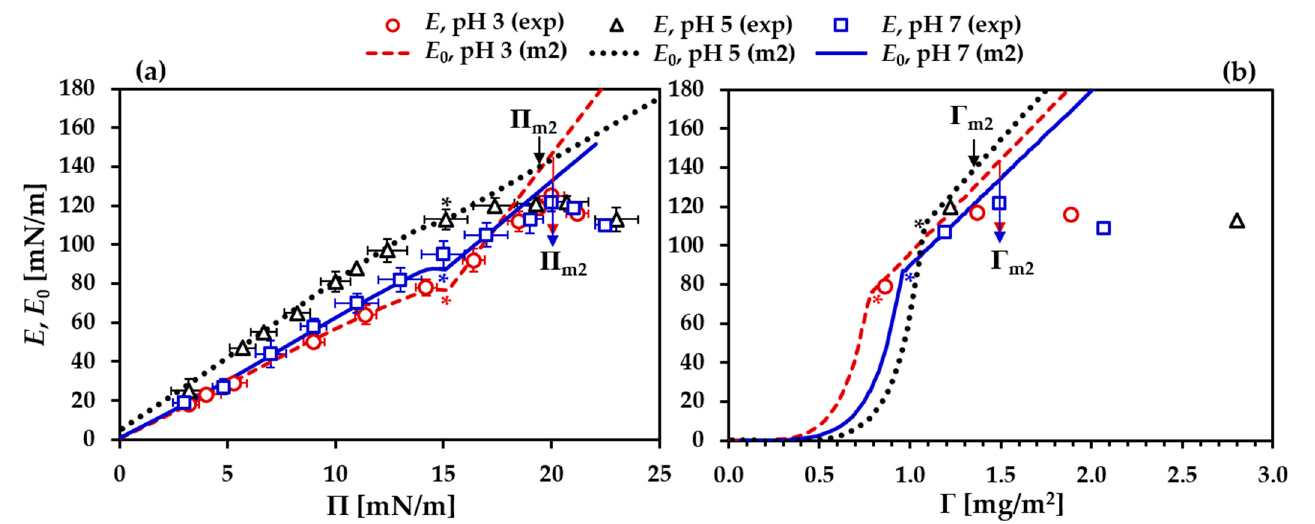
axis in the same way as in the isotherms of the surface pressure Π ( c ) and the surface excess Γ ( c ) (Figure 1) that follows from the theory.